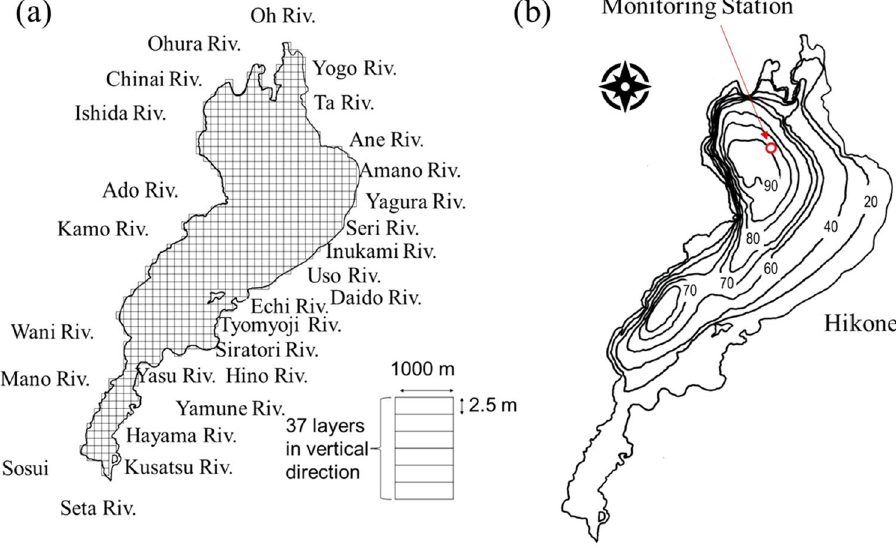
Figure 1. The map and computational conditions of Lake Biwa. Computational conditions for ( a ) the grid system and the 25 nearby rivers, ( b ) one station for water quality monitoring, and one station (Hikone) for meteorological